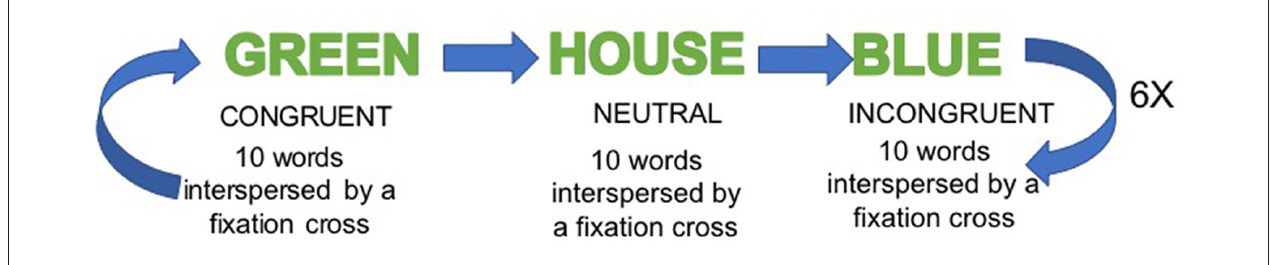
FIGURE 1 | Stroop Word-Color Task (SWCT) fMRI paradigm.